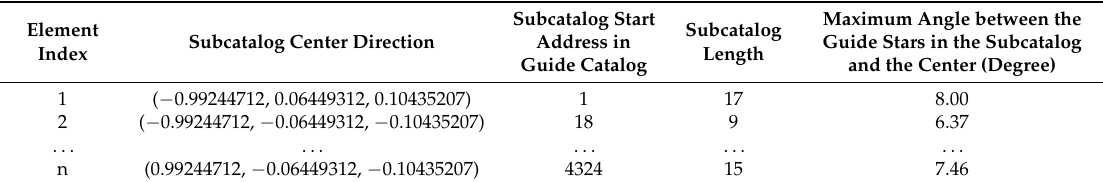
Table 2. Structure of the element in the partition